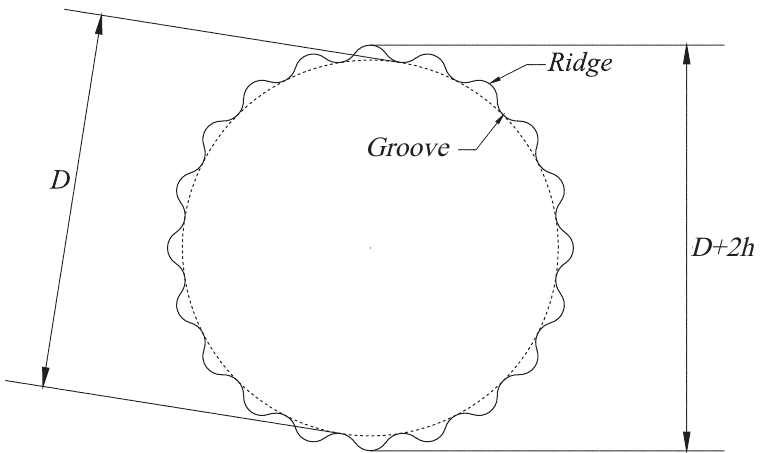
Figure 2. The cactus-shaped cross section with 20 ridges.